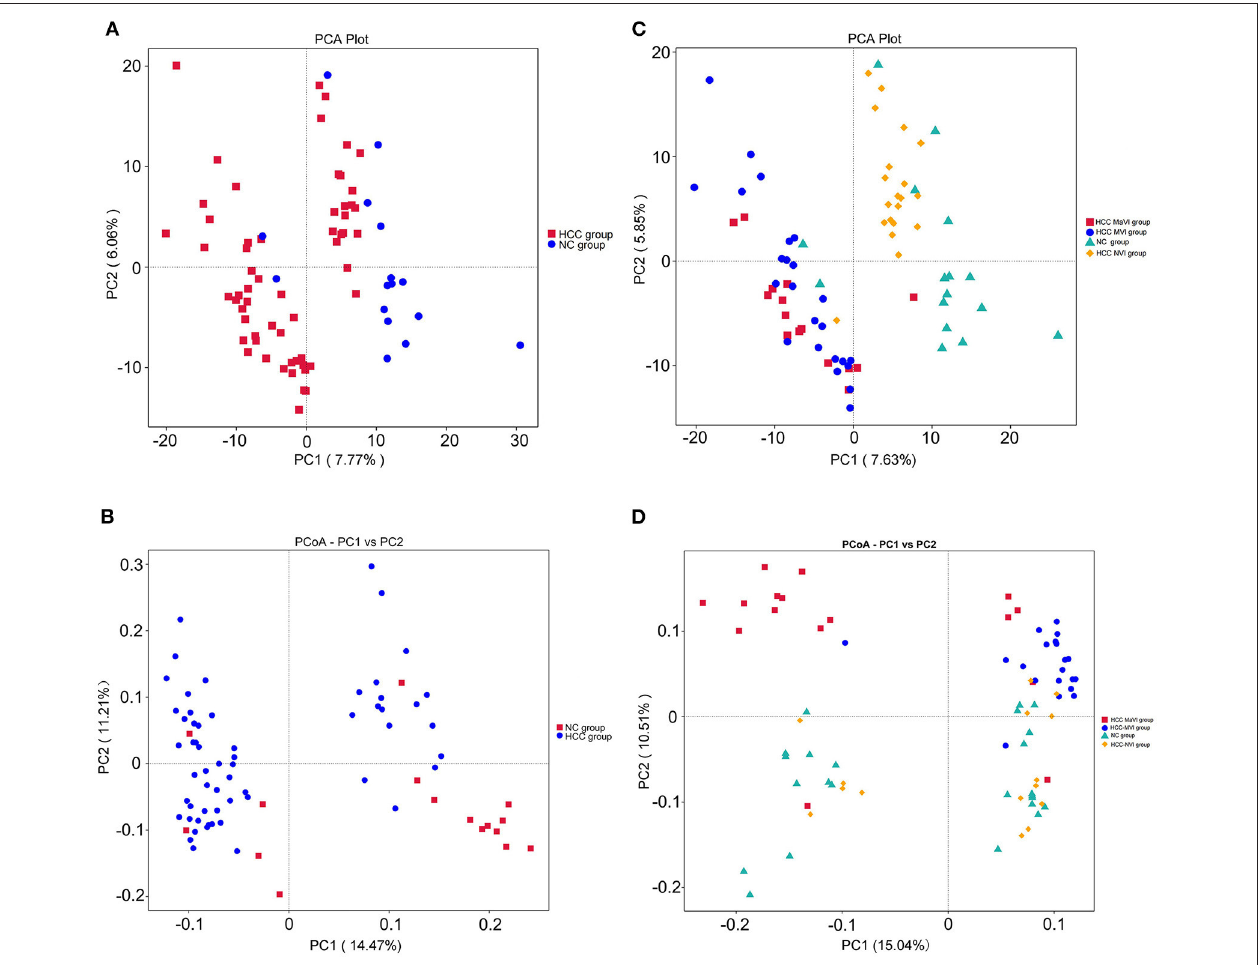
FIGURE 3 | Comparison of beta diversity by principal component analysis (PCA) and principal coordinate analysis (PCoA) plots. PCA (A) and PCoA analysis of variation based on unweighted UniFrac distances (B) of NC and HCC groups. Red and blue dots represent HCC and normal controls, respectively. Each point represents an individual sample. PCA (C) and PCoA analysis of variation based on unweighted UniFrac distances (D) of NC, HCC-NVI, HCC-MVI, and HCC-MaVI groups. Red dots represent HCC-MaVI, blue dots represent HCC-MVI, yellow dots represent HCC-NVI, and green dots represent the NC group, respectively. Each point represents an individual